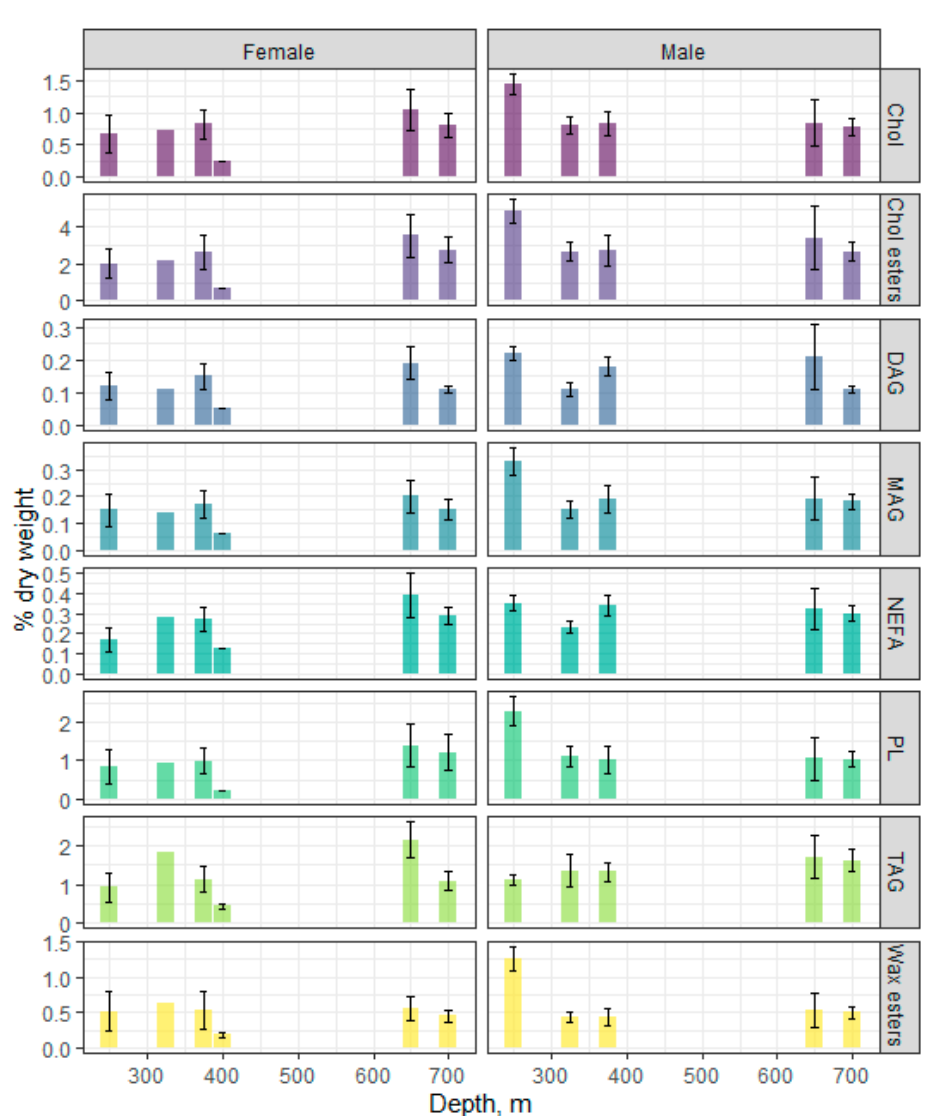
Figure 3. Changes in the content of individual lipid classes in the males and females of beaked redfish, Sebastes mentella, in the depth gradient of the Irminger Sea (North Atlantic). The content of the triacylglycerols (TAGs) and total phospholipids (PLs) in muscles 195 varied within 1.12–1.70 and 1.01–2.27% dry weight and within 0.44–2.14 and 0.23–1.39% 196